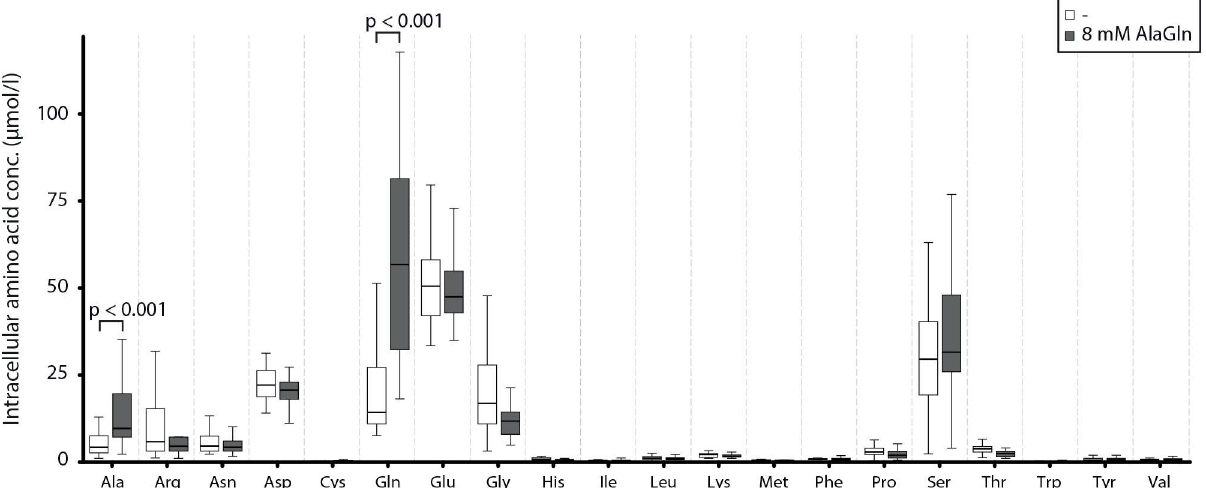
Fig 5. Intracellular glutamine of peripheral blood mononuclear cells (PBMC) following exposure to PD effluents obtained from the PET of patients treated with standard PDF or AlaGln-supplemented PDF. Intracellular amino acid concentrations of PBMC after exposure to effluent mixed 1:1 with fresh PDF for 4 h ( i . e . at the start time of LPS stimulation (see Fig 4, panel A) are shown. Of the 20 canonicalamino acids, only alanineand glutamineshow significantly higher intracellular concentrations when PBMC are exposed to effluents from patients treated with AlaGln-supplementedPDF (p < 0.001, n = 80 in each box (= 4 biologicalPBMC experiments exposed to 20 PD